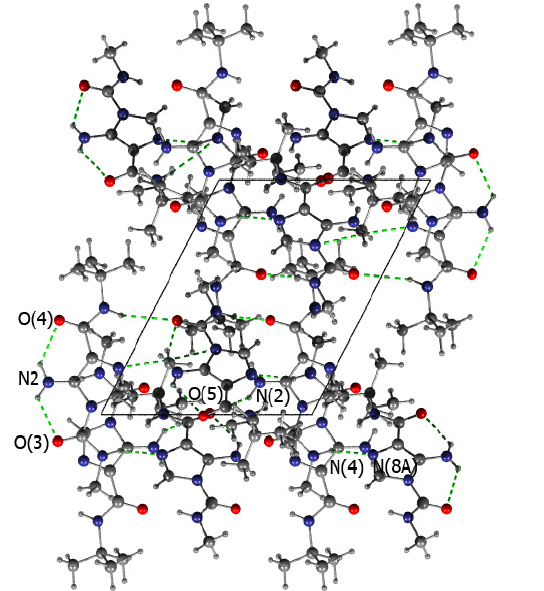
Figure 5. The view of crystal packing of TZ-5 along the y axis ( a ) and crystal packing of TZ-6 along the x axis ( b ). The hydrogen bond is marked by a green, dashed line.